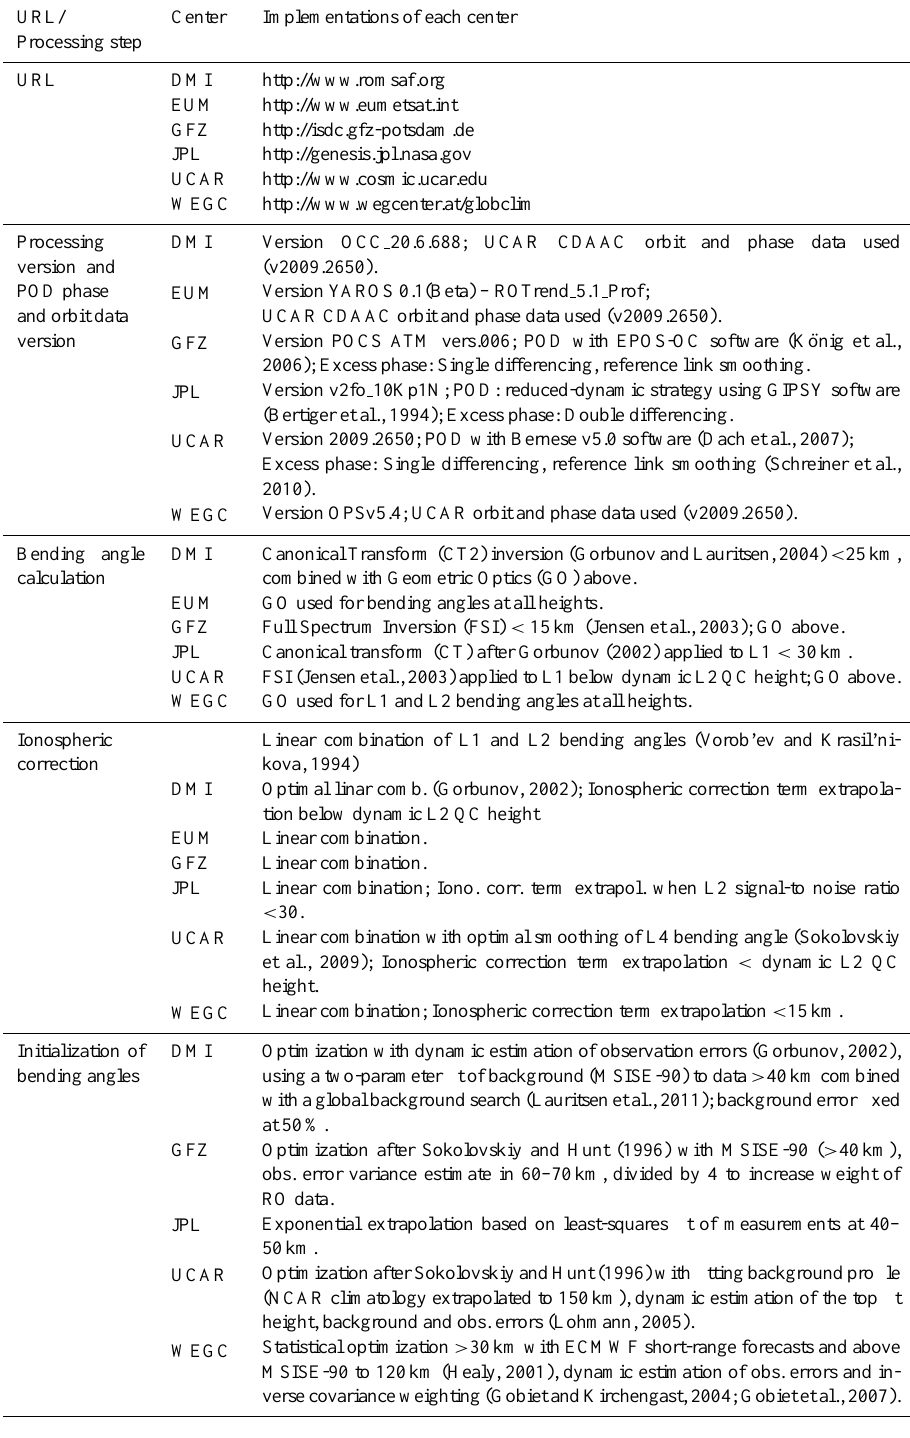
Table 1. Overview on processing chains at DMI, EUM, GFZ, JPL, UCAR, and WEGC (after Ho et al., 2012; Table 1 therein). URL/ Processing